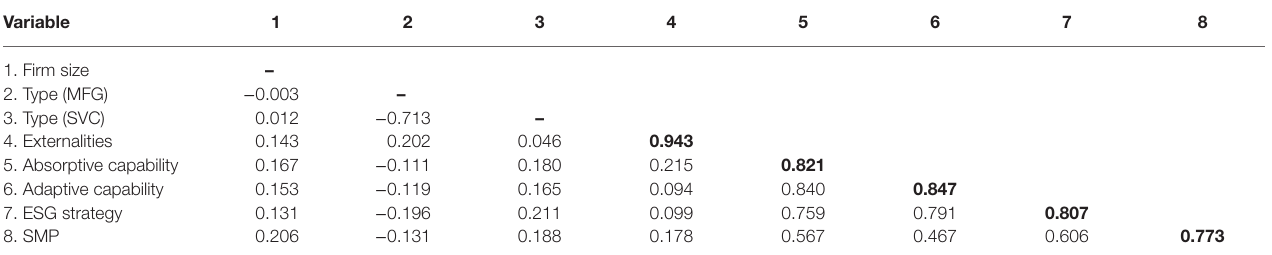
TABLE 3 | Fornell–Larcker